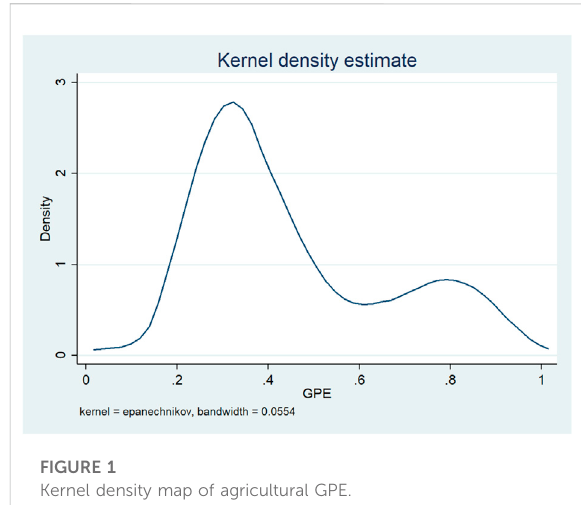
FIGURE 1 Kernel density map of agricultural